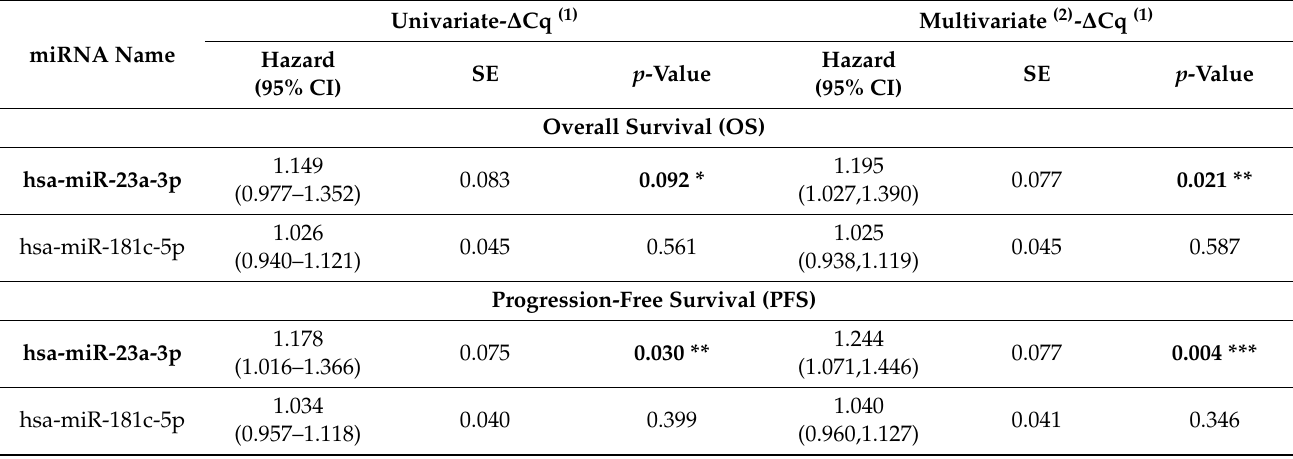
Table 5. Overall and progression-free survival analysis. OS and PFS analysis (Coxph) for miR-23a-3p and miR-181c-5p expression evaluated by RT-qPCR in Brescia cohort samples ( n = 145). Complete results for the multivariate analysis in Supplementary Results, Table S3.